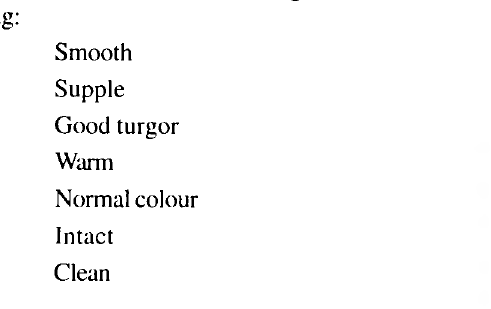
Figure 6 Outcome of beard care as percentage of